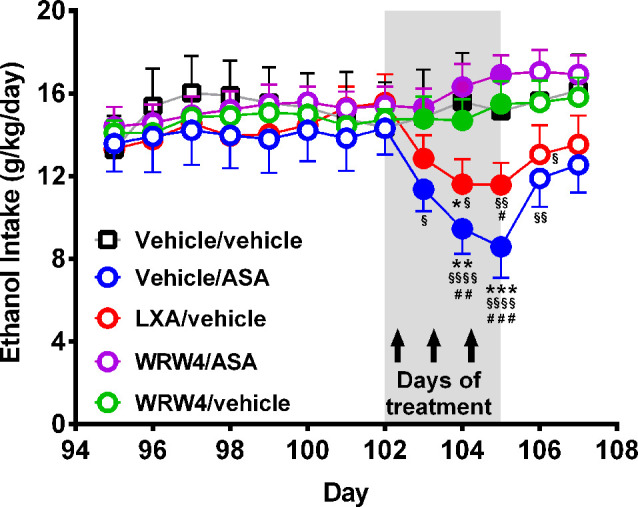
Oral administration of acetylsalicylic acid (ASA) or intravenous administration of lipoxin A4 inhibited chronic ethanol intake an effect that was fully blocked by the administration of WRW4, an antagonist of the lipoxin FPR2/ALX receptor. Rats chronically ingesting ethanol for 102 days were treated for three consecutive days with either: vehicle, ASA (15 mg/kg, p.o.), lipoxin A4 (LXA; 7 μg/kg, i.v.), or WRW4 (0.3 mg/kg administered i.v. 5 min prior to ASA or vehicle). Acetylsalicylic acid or LXA A4 treatment reduced chronic ethanol intake compared to the vehicle group [two-way analysis of variance indicates significant effect of treatment (Ftreatment(4, 108) = 14.23, ***P < 0.001) but not of day (Fday(5, 108) = 1.262, P = 0.2856)]. Tukey post hoc test revealed that the administration of three daily doses of ASA reduced ethanol intake: vs. the vehicle group (**P < 0.01, the second and ***P < 0.001 the third day of treatment), vs. the WRW4/ASA group (§P < 0.05 the first, §§§P < 0.001 the second, §§§§P < 0.0001 the third day of treatment, and §§P < 0.01 the first posttreatment day) and vs. the WRW4/vehicle group (##P < 0.01, the second and ###P < 0.01 the third day of treatment). In the same way, three daily doses of lipoxin A4 reduced ethanol intake: vs. vehicle group (*P < 0.05, the second day of treatment), vs. the WRW4/ASA group (§P < 0.05 the second, §§P < 0.01 the third day of treatment, and §§P < 0.01 the first posttreatment day) and vs. the WRW4/vehicle group (#P < 0.05, the third day of treatment). Data are presented as mean ± SEM, n = 6 rats per experimental group.